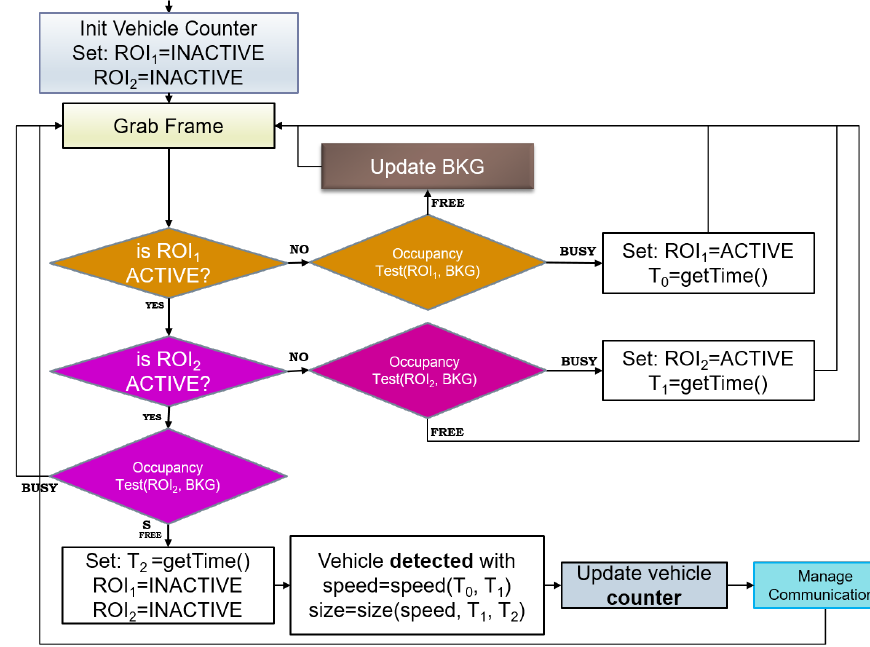
Figure 3. Flow chart of the traffic flow monitoring